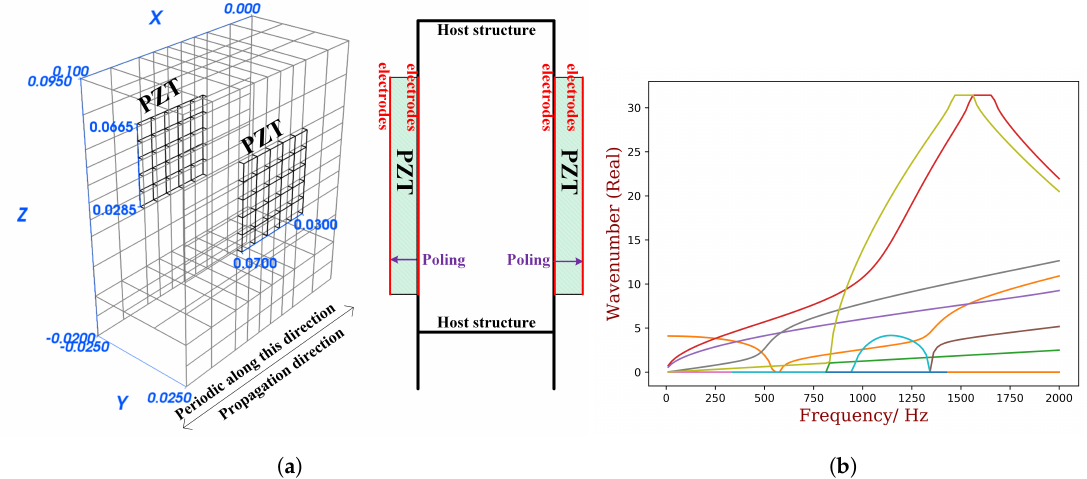
Figure 11. The unit cell of the thin-wall piezoelectric structure ( a ) and its dispersion curves ( b ). The program code used to generate the Finite Element model in ANSYS can be found in the Supplementary Files.